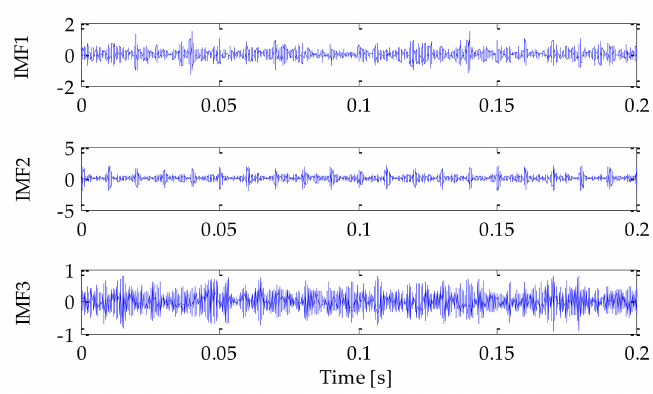
Figure 9. VMD decomposition